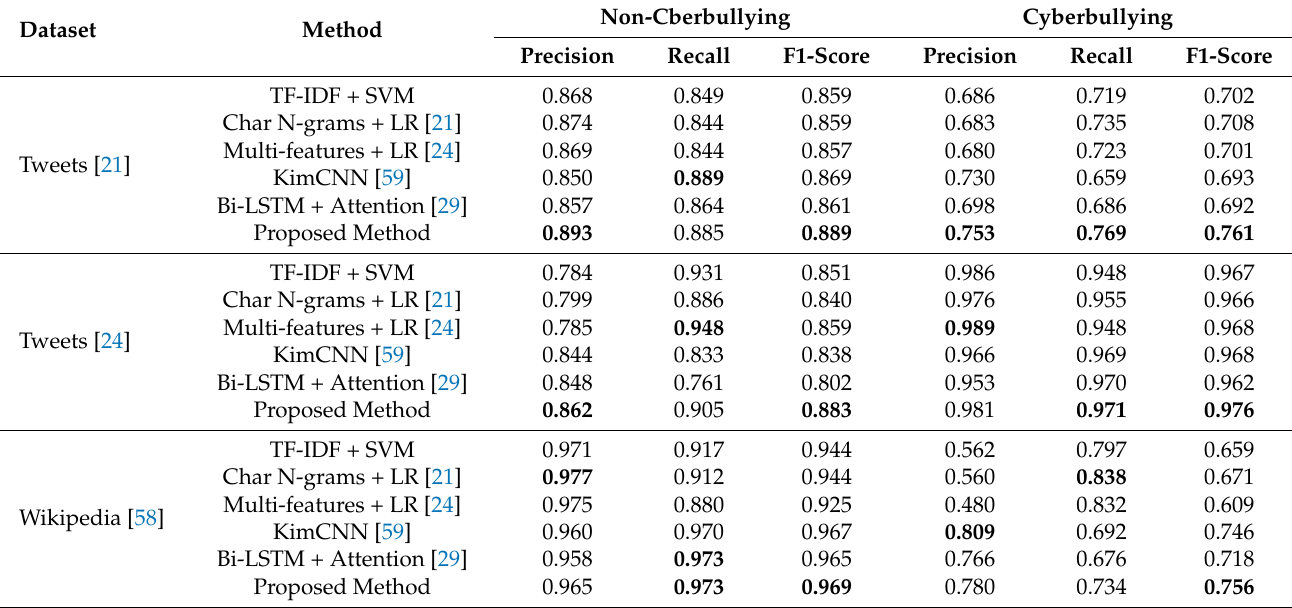
Table 4. Experiment Result for Each